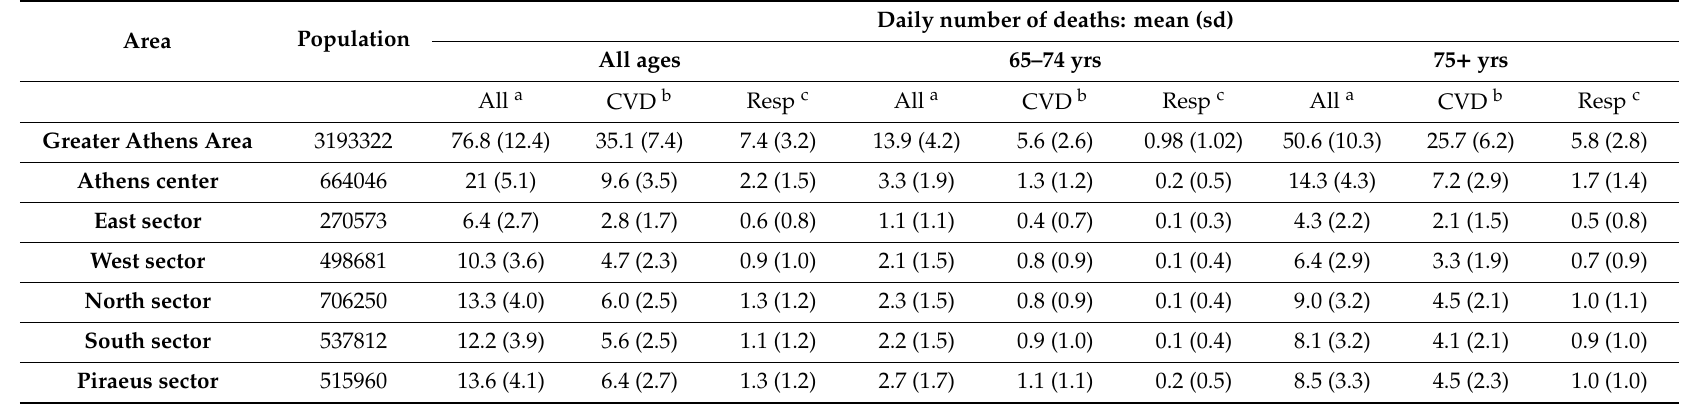
Table 2. Population and daily number of deaths for the Greater Athens Area and by sector, 1 / 04 to 30 / 09,